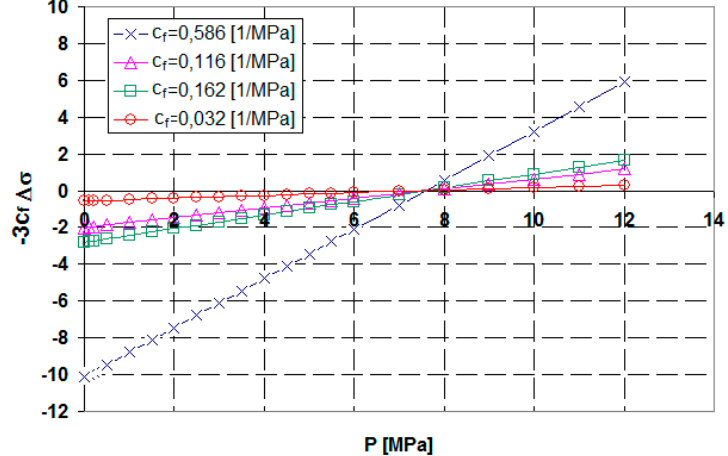
Figure 4. Deformations caused solely by the geomechanical action of the pore pressure based on the Cui and Bustin model.